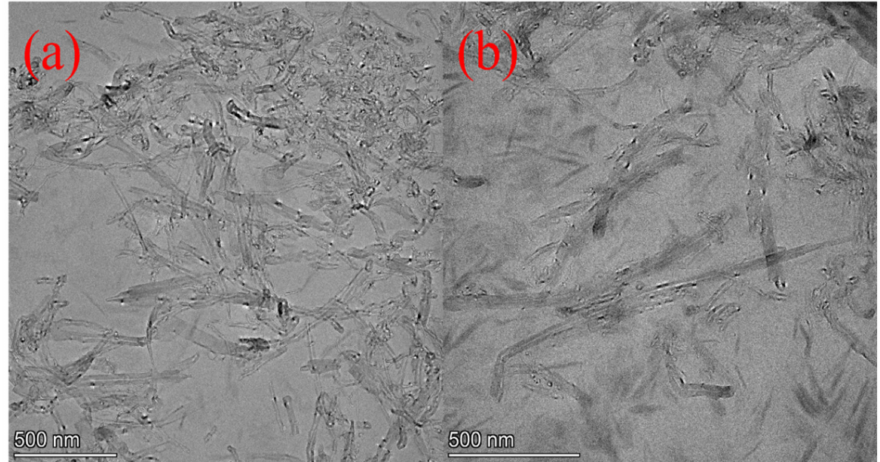
Figure 3. TEM images of ( a ) EP-M-1.0%. ( b )